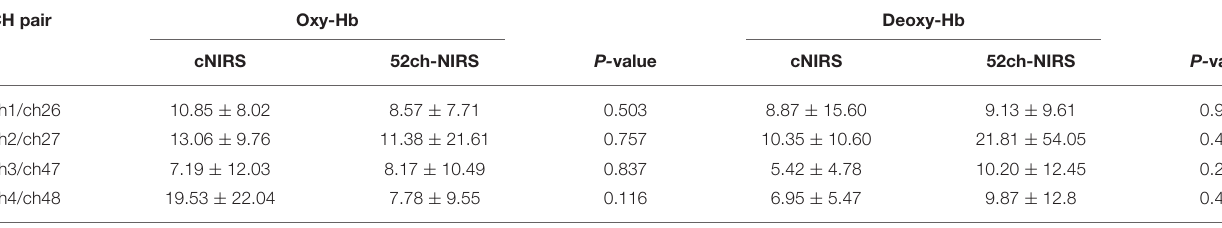
TABLE 1 | Comparisons of signal to noise ratio (SNR) between cNIRS and 52ch-NIRS. CH